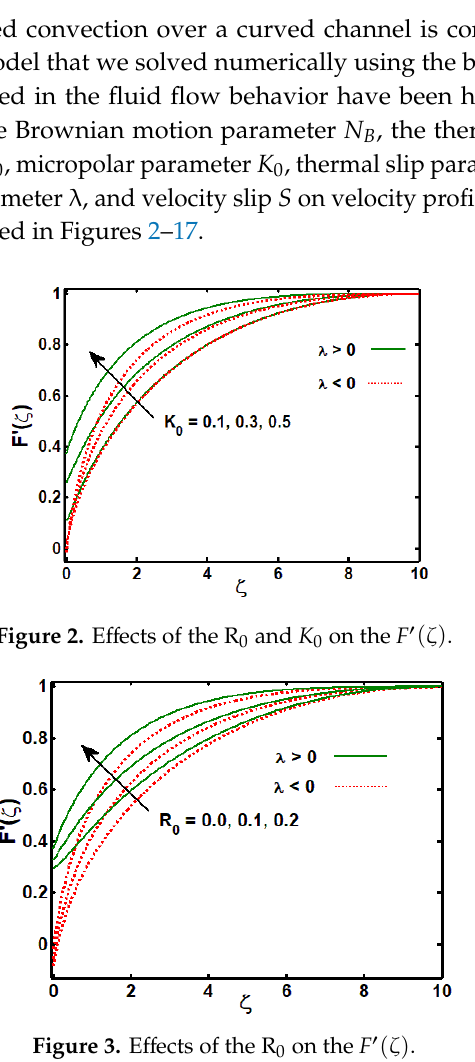
Figure 3. E ff ects of the R 0 on the F (cid:48) ( ζ ) Figure 3. Effects of the R 0 on the 𝐹′(𝜁) . Figure 3. Effects of the R 0 on the 𝐹′(𝜁) .